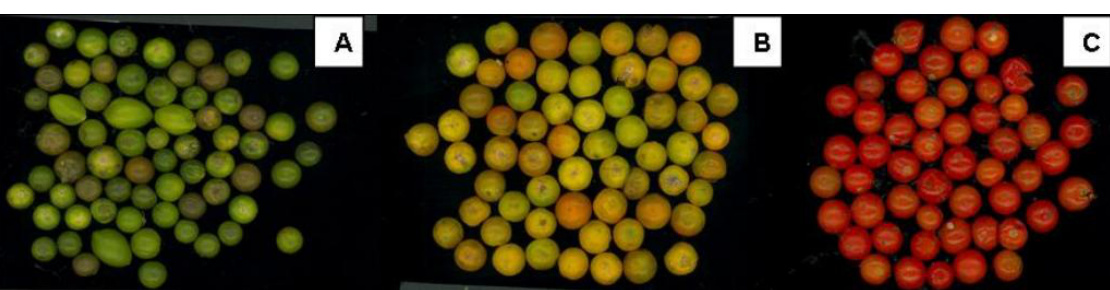
Figure 1. Solanum indicum L. berries at different ripening stages (green, A; yellow, B; red,